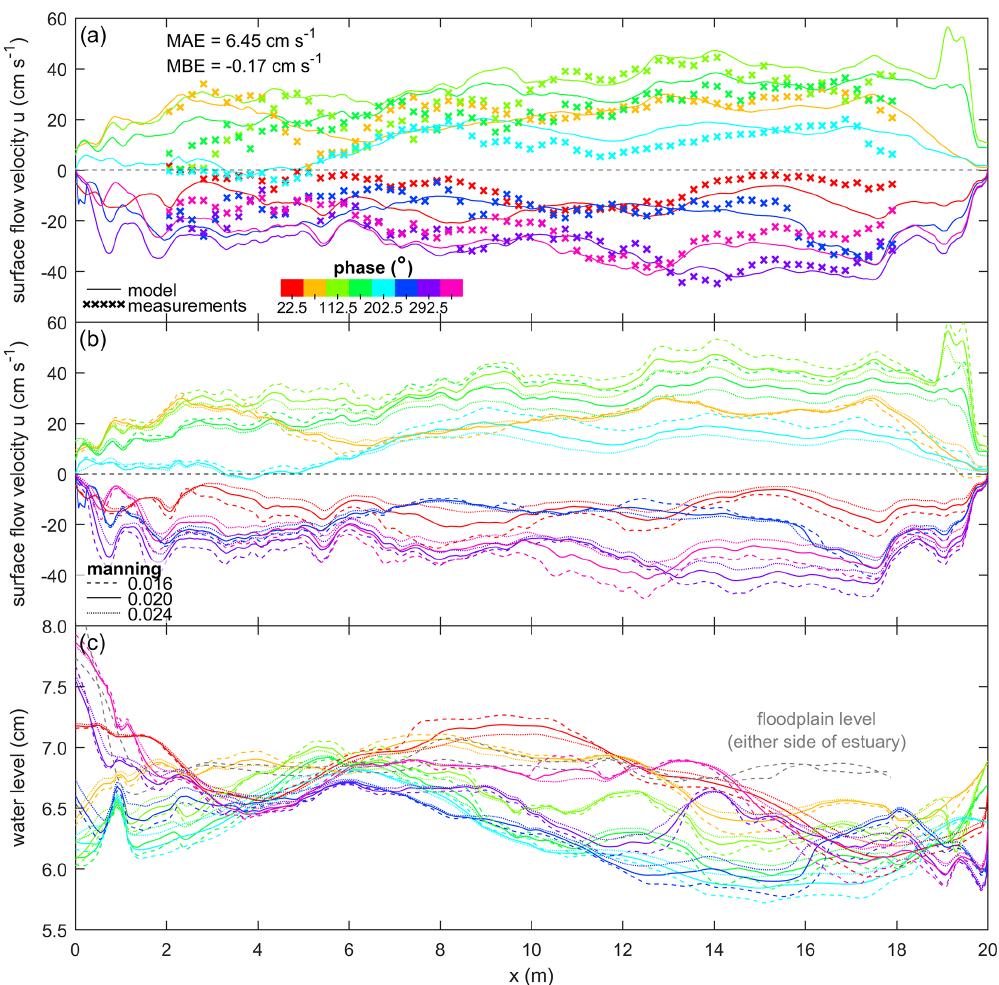
Figure 7. (a) Surface flow velocity along the estuary, given as the 90th percentile of the streamwise flow velocity component. (b) The effect of Manning on the surface flow velocity and (c) the phase-dependent median water level of each cross section along the estuary. Colours indicate the phase in the tidal cycle.